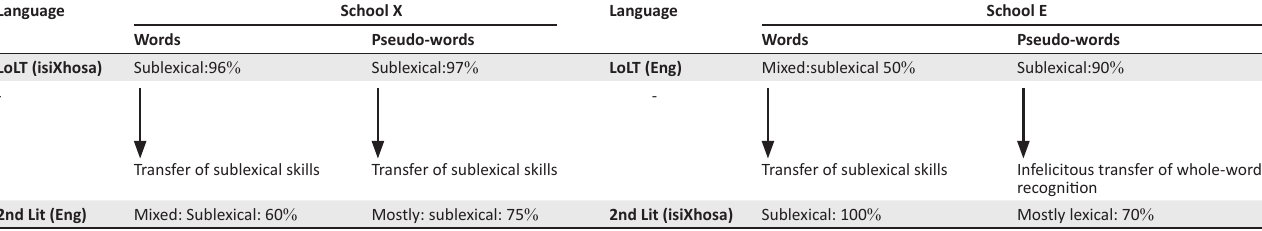
TABLE 4: Summary of the different word recognition strategies employed.